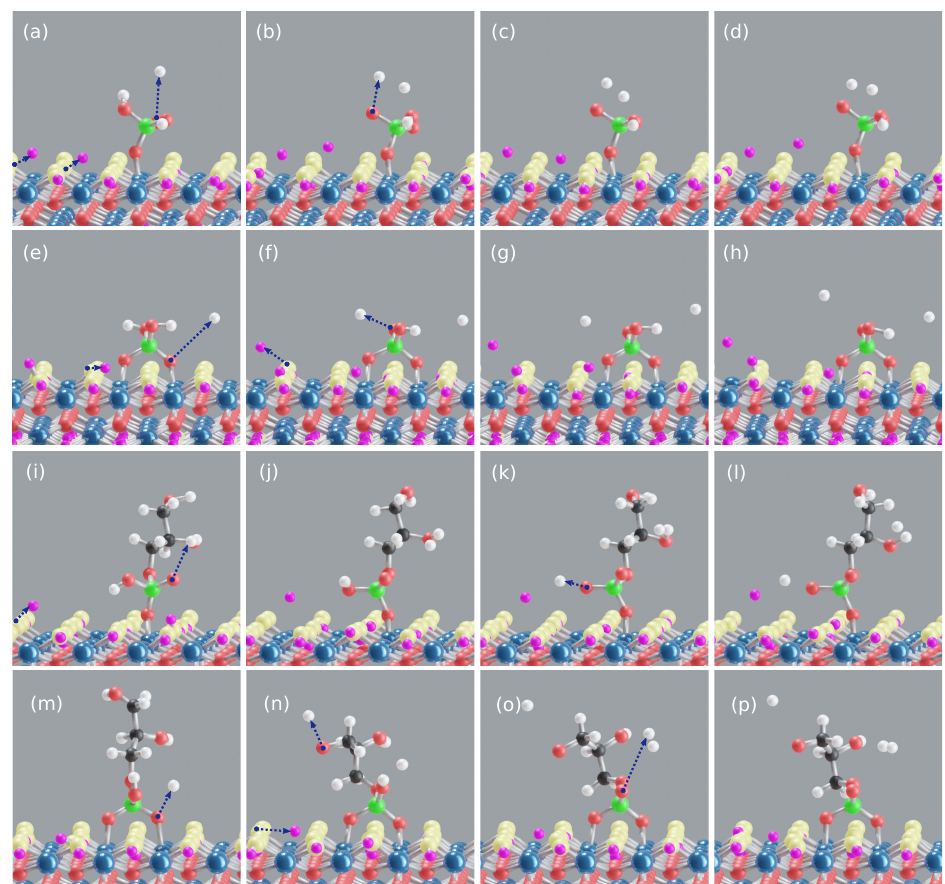
Figure 3. Snapshots along the simulation trajectories of the goethite–OP/GP/IHP–water complexes. OP M motif ( a – d ), OP B motif ( e – h ), GP M motif ( i – l ), GP B motif ( m – p ). Arrows denote proton transfers from phosphates to water and from goethite to water. For all cases, the first two snap- shots are from equilibration phase while the last two are from production, except for OP M motif case where only ( a ) is from equilibration phase. The last snapshot for each case is taken at 25 ps. The goethite’s hydrogen atoms and OP/GP/IHP’s hydrogen atoms are shown in violet and white colors, respectively, for clear visualization of proton transfer events. Blue, red, yellow, black and green colors correspond to iron, bridging oxygen, hydroxyl oxygen, carbon and phosphorus atoms, respectively. The surrounding water is ignored here for better visualization. Table 2. The interaction energies per number of bonds (E int /bond) and selected interatomic